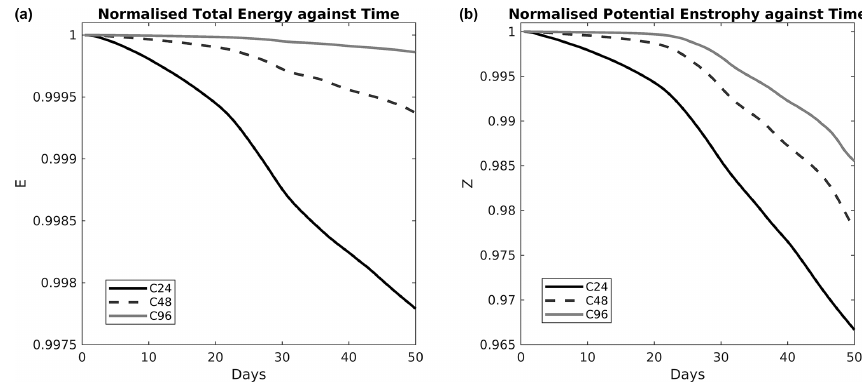
Figure 7. The normalised total energy (a) and potential enstrophy (b) against time for the Williamson mountain test.